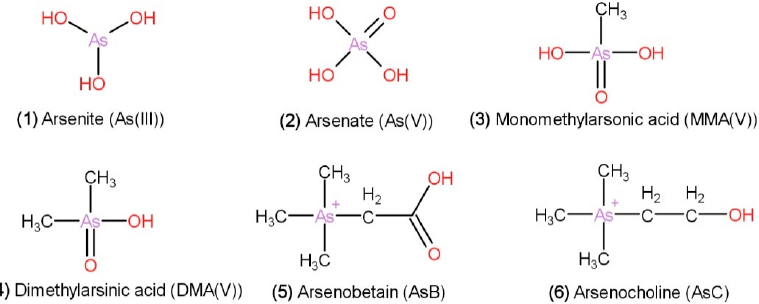
Figure 5. Chemical structures of arsenic compounds found in H. fusiformis . ( 1 ) Arsenite (As(III)); ( 2 ) arsenate (As(V)); ( 3 ) monomethylarsonic acid (MMA(V)); ( 4 ) dimethylarsinic acid (DMA(V)); ( 5 ) arsenobetaine (AsB); ( 6 ) arsenocholine (AsC). Wagle et al. [65] investigated the activities of glycyrrhizin isolated from H. fusiformis , including its metabolites, 18 α - and 18 β -glycyrrhetinic acid, in Alzheimer’s disease preven- tion. Glycyrrhizin, commonly known as glycyrrhizic acid (GLR) or licorice, is a saponin molecule made up of glycyrrhetic acid, a triterpenoid aglycone, and glucuronic acid disac- charide. GLR is frequently extracted using an ethanol solution at high temperatures